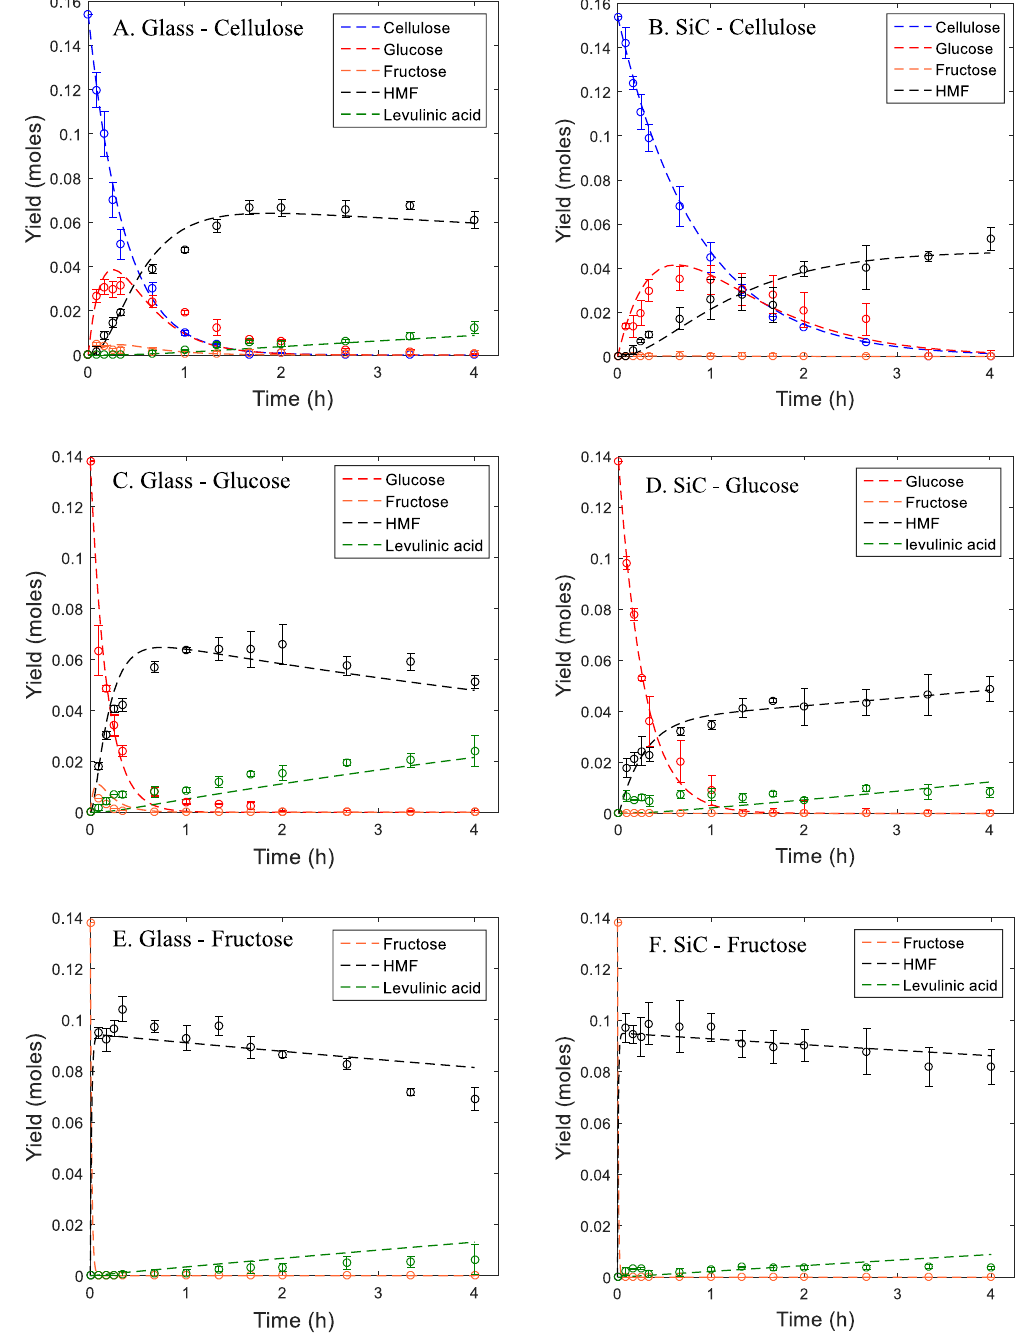
Figure 5. Conversion of cellulose, D-glucose and D-fructose under (Left) microwave irradiation (glass) and (Right) conventional heating